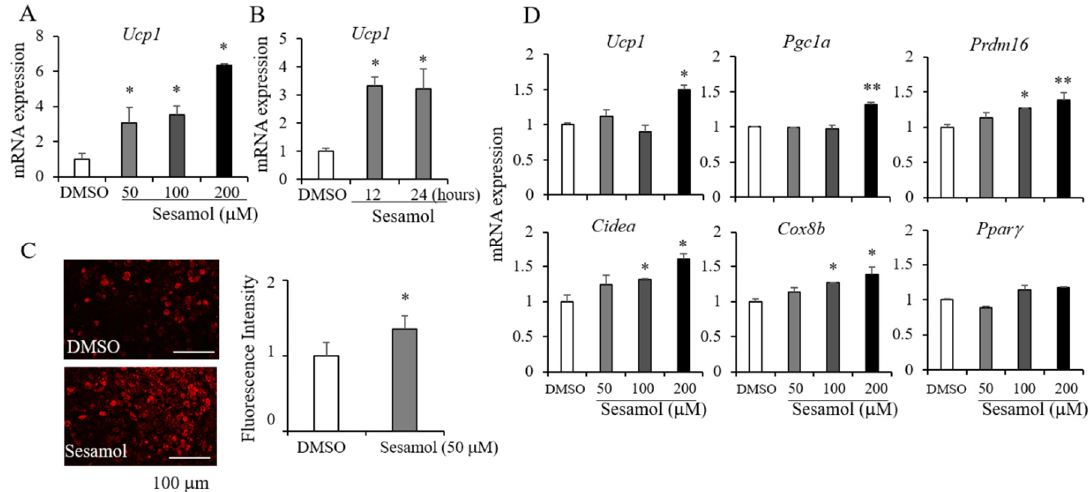
Figure 1. Sesamol induces the expression of Ucp1 in adipocytes. ( A ) Differentiated C3H10T1/2 adipocytes were treated with sesamol for 12 h at the indicated doses (50, 100, and 200 μM) and the expression of Ucp1 was measured. ( B ) Primary adipocytes isolated from inguinal adipose tissues were treated with 50 μ M of sesamol for 12 or 24 h and the Ucp1 expression was measured. ( C ) Mitochondrial staining by mitochondria-specific CytoPainter (ab112145) in C3H10T1/2 adipocytes treated with dimethyl sulfoxide (DMSO) or sesamol (50 μM) for 24 h and mitochondrial staining was quantified using the National Institutes of Health’s (NIH) Image J software. ( D ) Differentiated T37i brown adipocytes were treated with sesamol (50, 100, 200 μM) for 12 h and the levels of thermogenic selective markers ( Ucp1 , Pgc1α , Prdm16 , Cidea , and Cox8b ) and Pparγ were measured by real-time PCR. Data represent means ± s.e.m. and are representative of three independent experiments. Statistical significance was determined relative to a control using the Student’s t -test (* p < 0.05; ** p < 0.005).